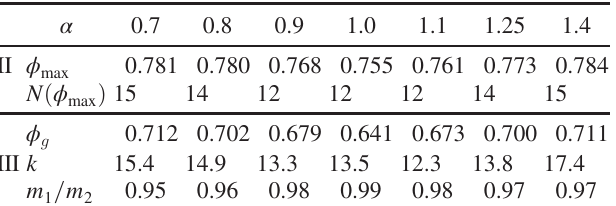
TABLE I. Properties of densest local structures for ellipsoids with aspect ratio α (see Sec. II). Global packing density ϕ disordered Lubachevsky-Stillinger packings analyzed in Sec. III, and the best-fit parameters of the k -Gamma background (see text). A fraction m 1 =m 2 of all particles can be attributed to the